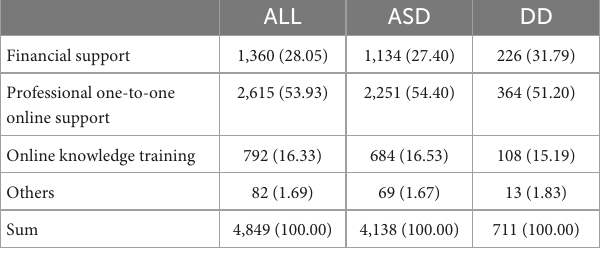
TABLE 5 Responses to the open-ended question about what could be of help to deal with the conditions of the ongoing